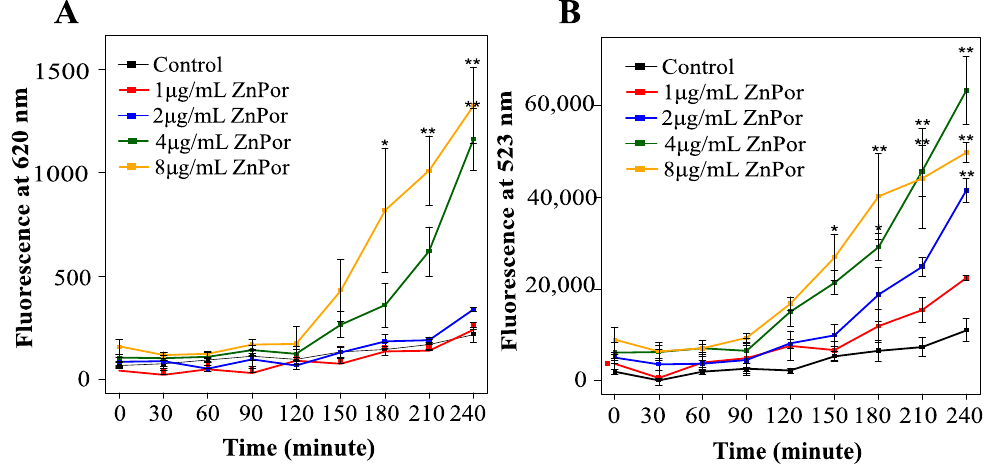
Figure 5. ZnPor effect on PsA permeability: PsA was grown overnight in MSG at 37 °C, diluted to 0.15 OD with fresh MSG, and subsequently treated with ZnPor at concentrations of 1 to 8 µg/mL (incubated at 37 °C at 180 rpm). Samples were removed at various time points and washed 2× with Tris buffer (pH 7.2) ( A ) ZnPor uptake: fluorescence analysis was completed (at 433 and 620 nm). ( B ) SYTOX TM Green permeability assay: samples were treated with SYTOX TM Green dye (10 min at 37 °C), and fluorescence (523 nm) was measured. Please note the lack of SYTOX TM Green dye fluorescence in control cells not pre-treated with ZnPor. ZnPor at concentrations as low as 1 µg/mL resulted in permeabilization sufficient to allow the impermeable dye to enter and to bind to DNA. All data points represent mean ± SD of three independent experiments ( n = 9). p values: * represents 0.05, and ** represents 0.002.